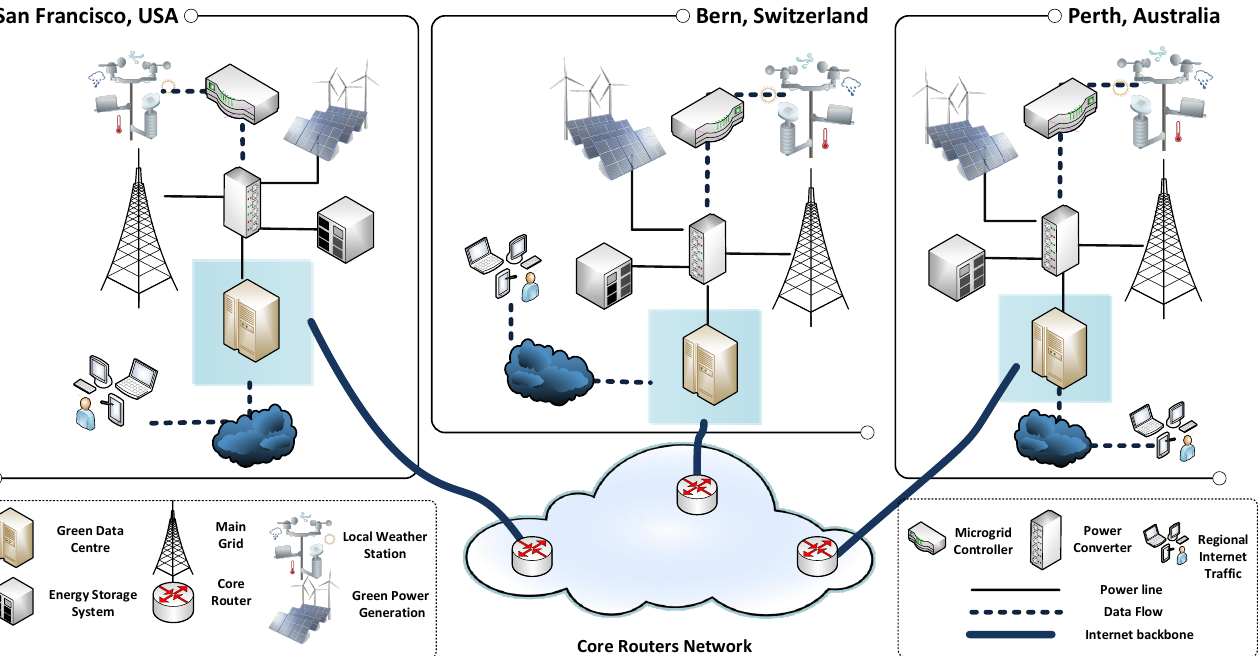
Figure 6. Case study of the three integrated green data centres located in Australia, California, and